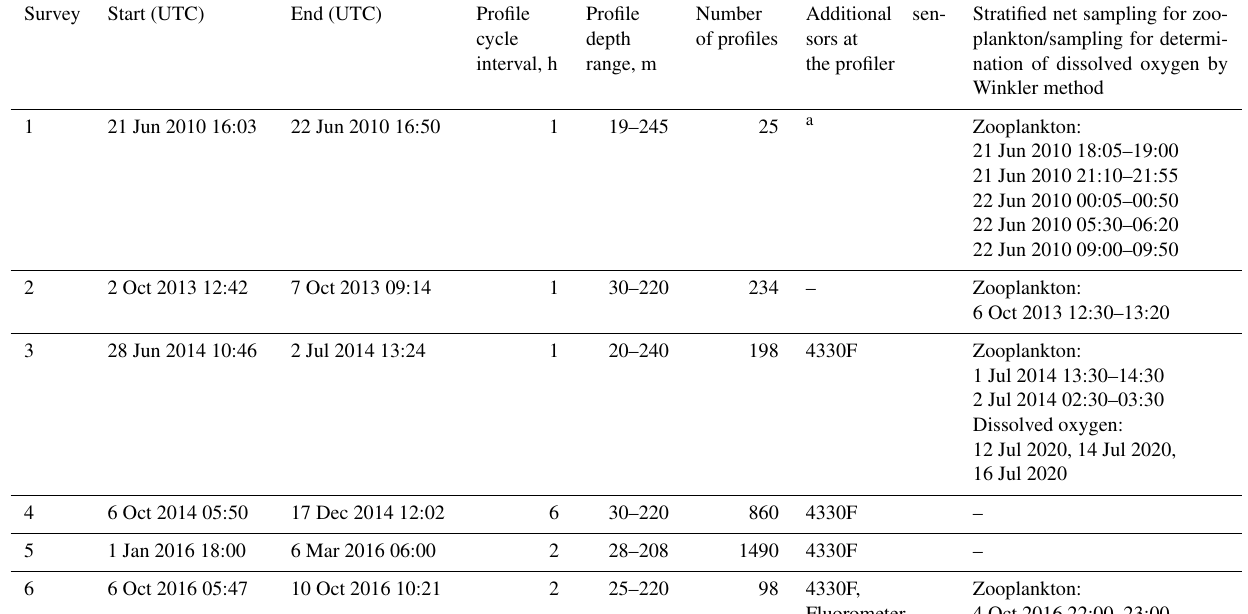
Stratified net sampling for zoo- plankton/sampling for determi- nation of dissolved oxygen by the profiler Winkler